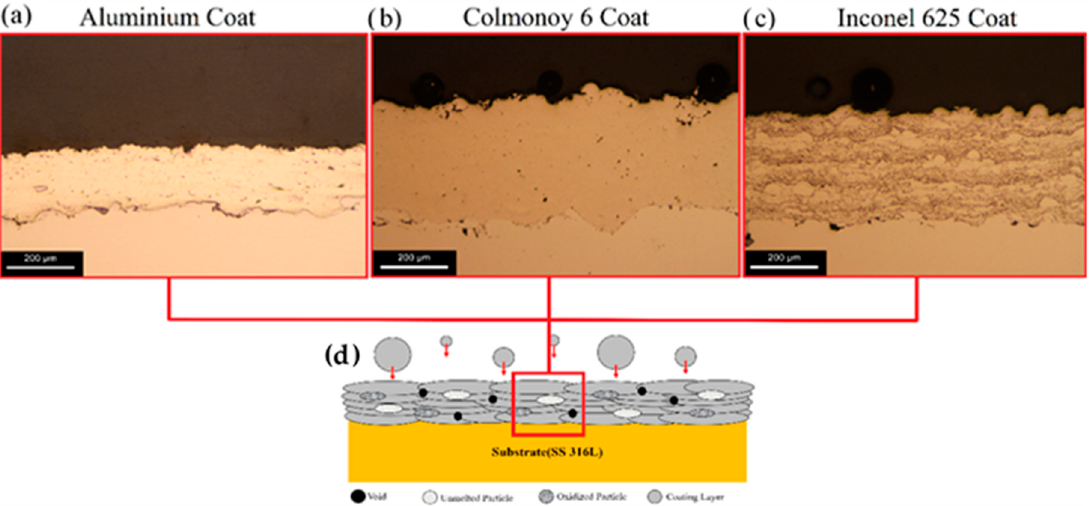
Figure 2. Optical microscope micrographs of ( a ) Al, ( b ) Colmonoy, ( c ) Inconel coatings, and ( d ) a schematic of how particles hit the surface during the HVOF process.